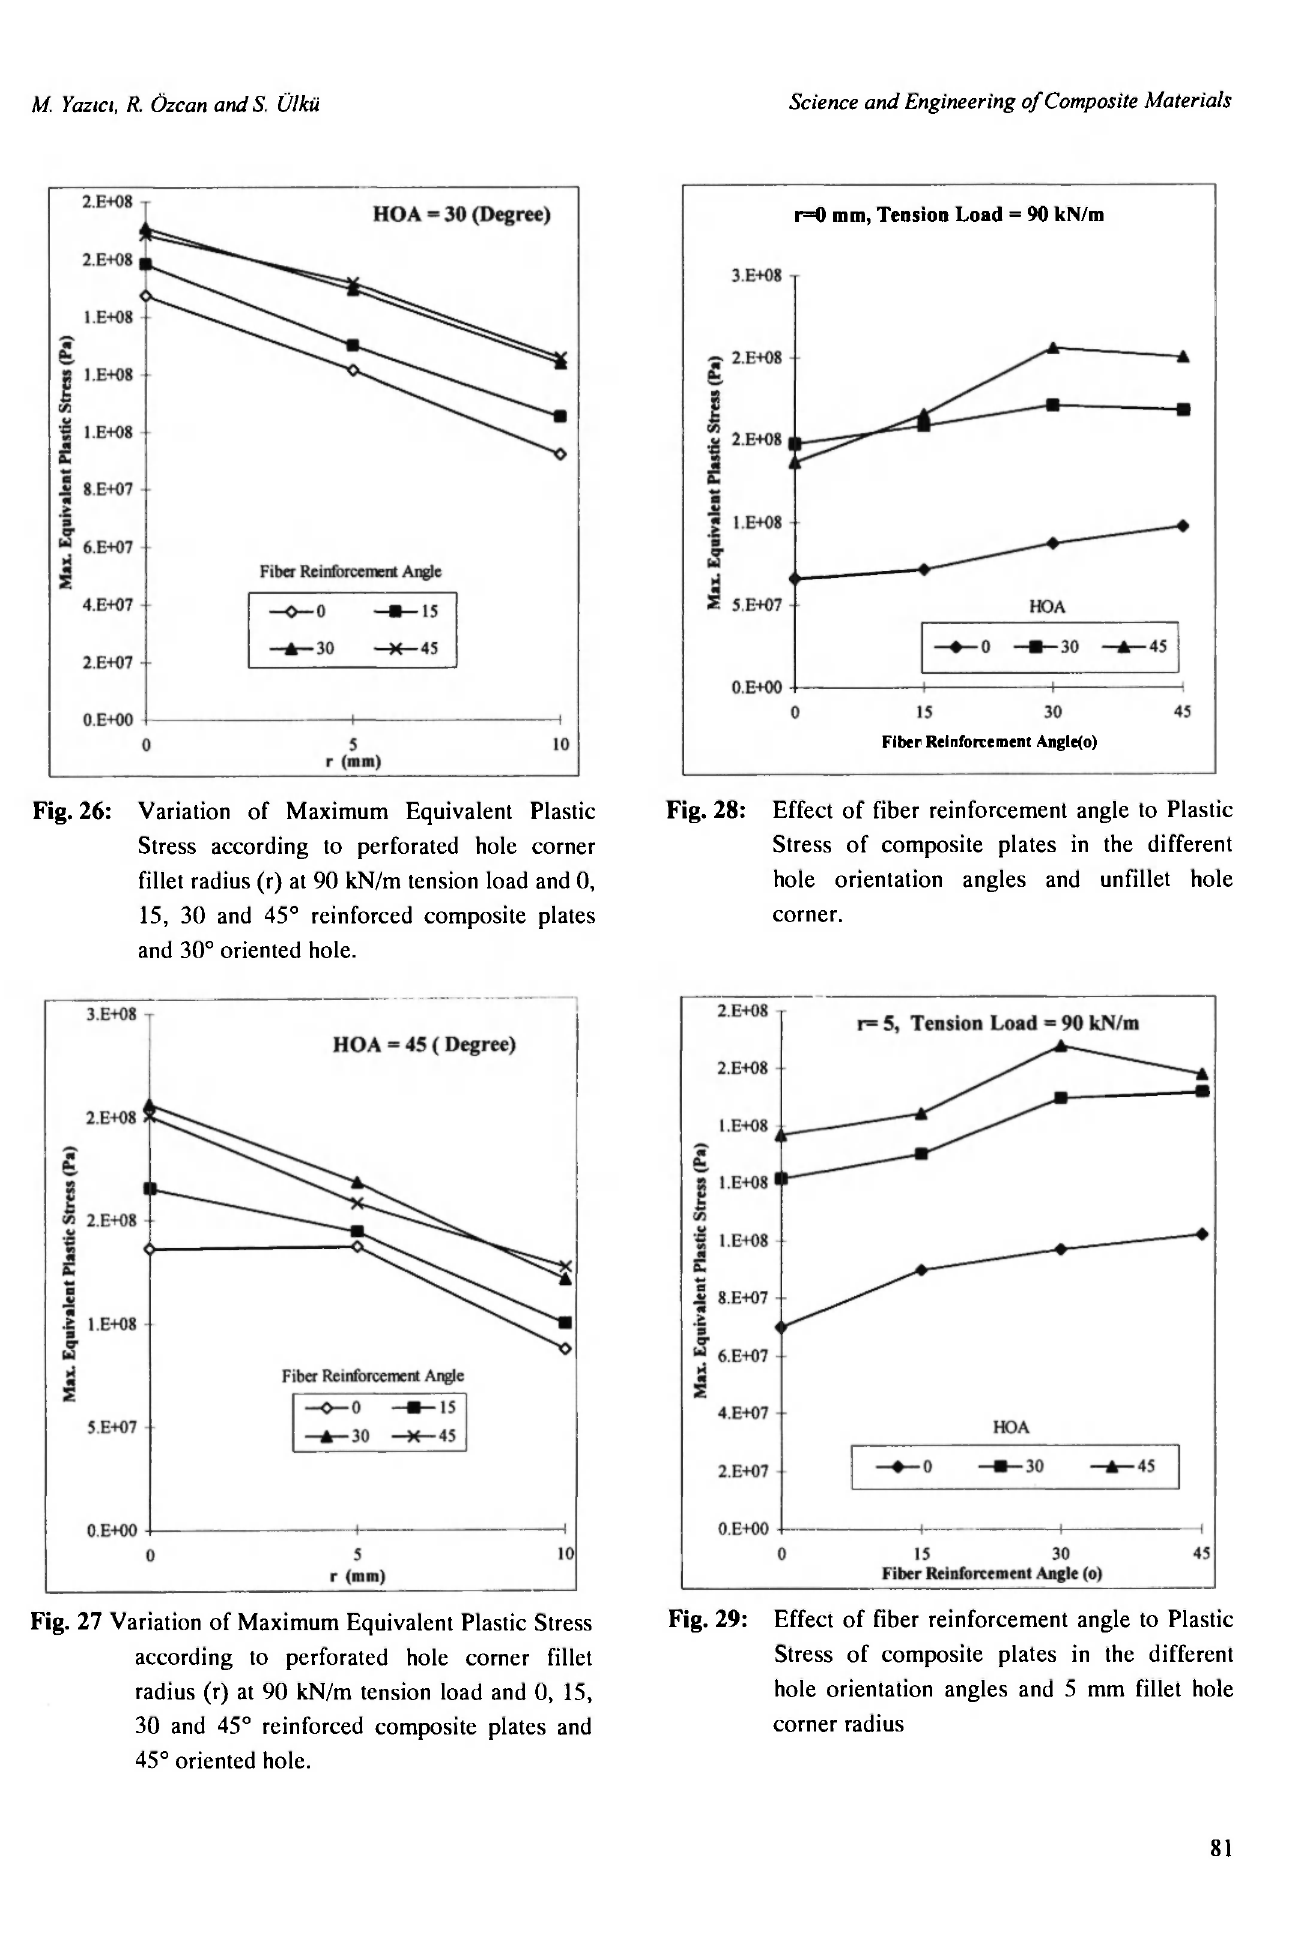
Fig. 29: Effect of fiber reinforcement angle to Plastic Stress of composite plates in the different hole orientation angles and 5 mm fillet hole corner radius